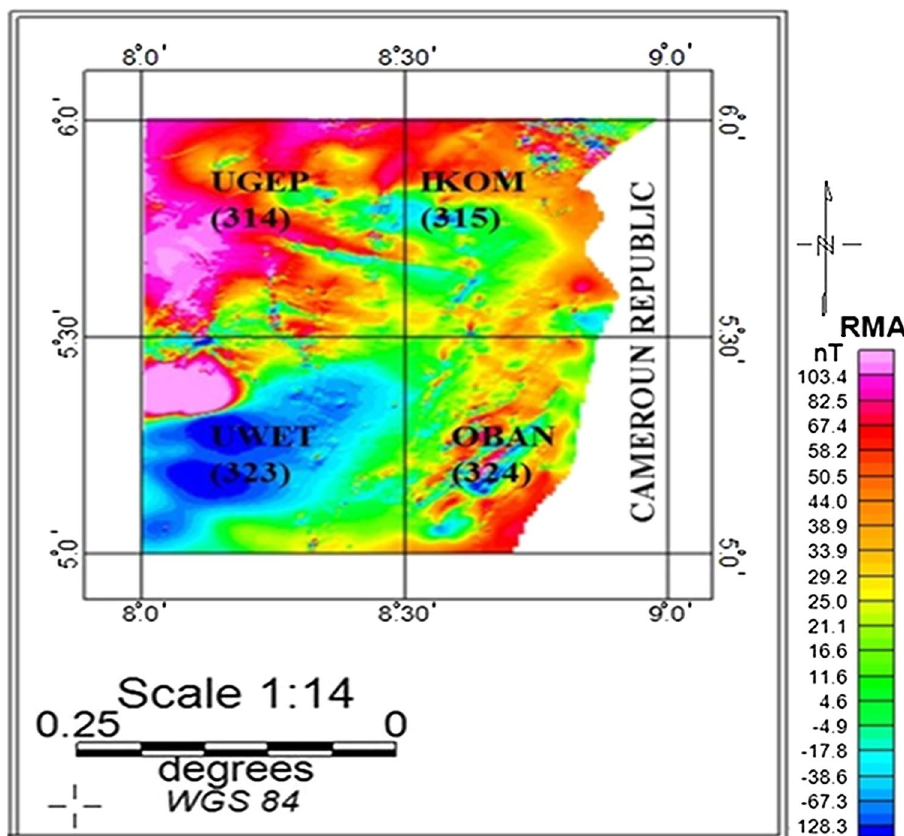
Fig. 3 Uwet, Oban, Ugep and Ikom combined residual mag- netic anomaly